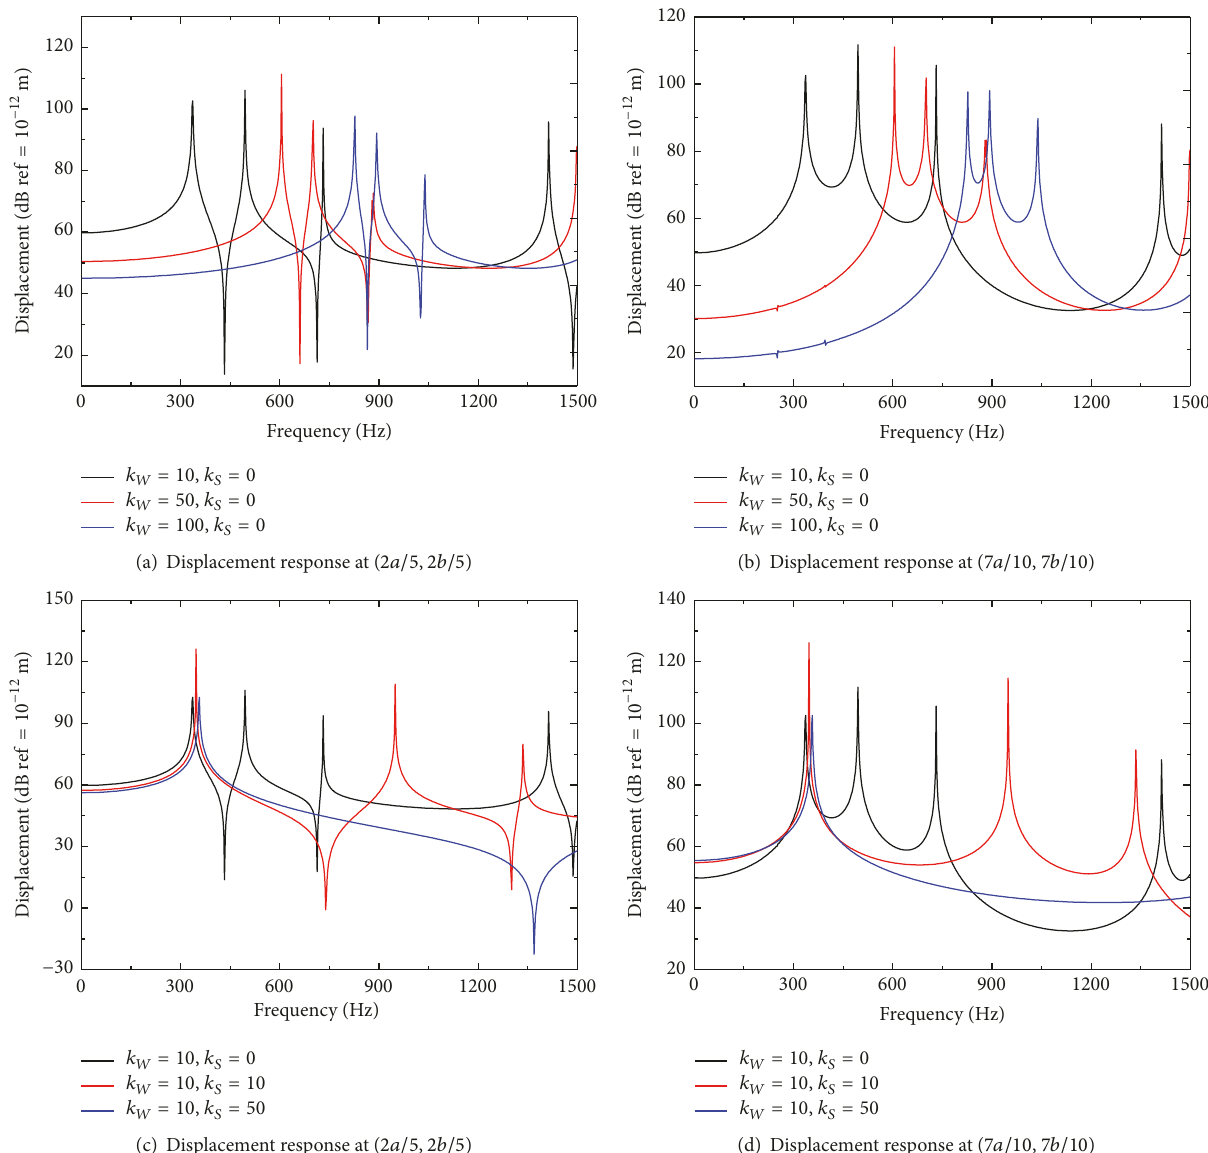
frequency of the plates are presented. The forced vibration response of plate is studied by applying an external harmonic point force. Vibration displacement response of the plate with various thicknesses, elastic boundary constraints, and elastic foundation parameters is investigated, which can provide a benchmark for the future